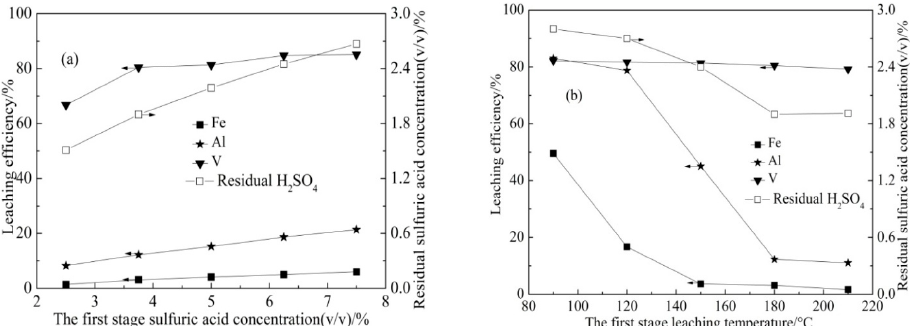
Figure 4. Effects of sulfuric acid concentration ( a ); and temperature ( b ) on the dephosphorization rate and the vanadium loss